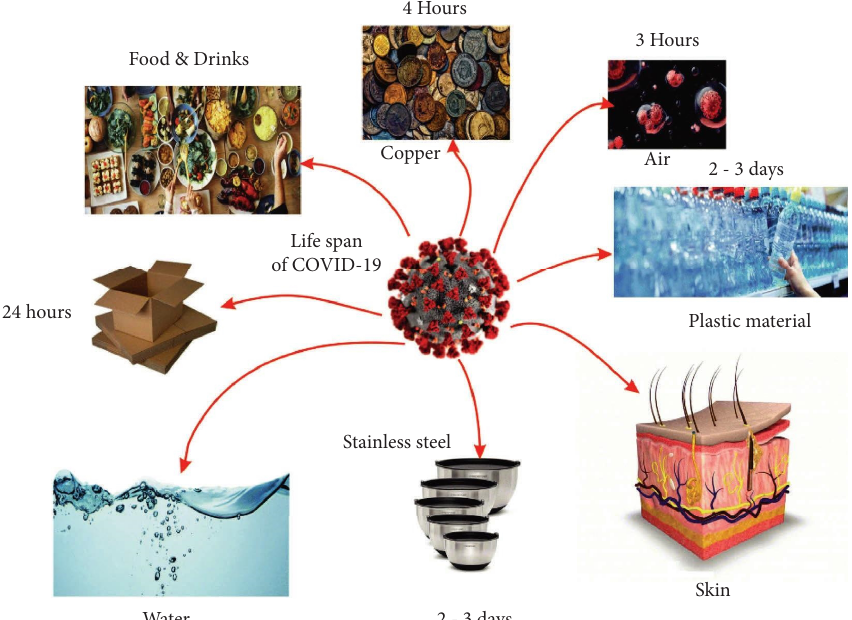
Figure 1: The life span of the COVID-19 virus on different surfaces